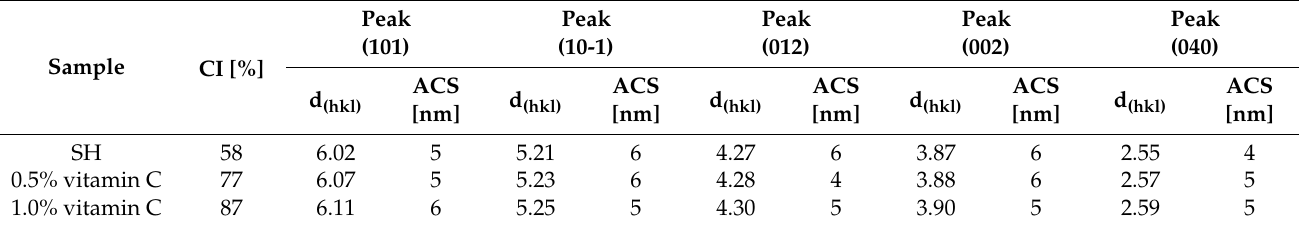
Table 1. Crystallinity index, the interplanar crystal distance and the average crystallite size of BNC produced in SH me- dium and SH medium supplemented with 0.5% or 1.0% vitamin C.